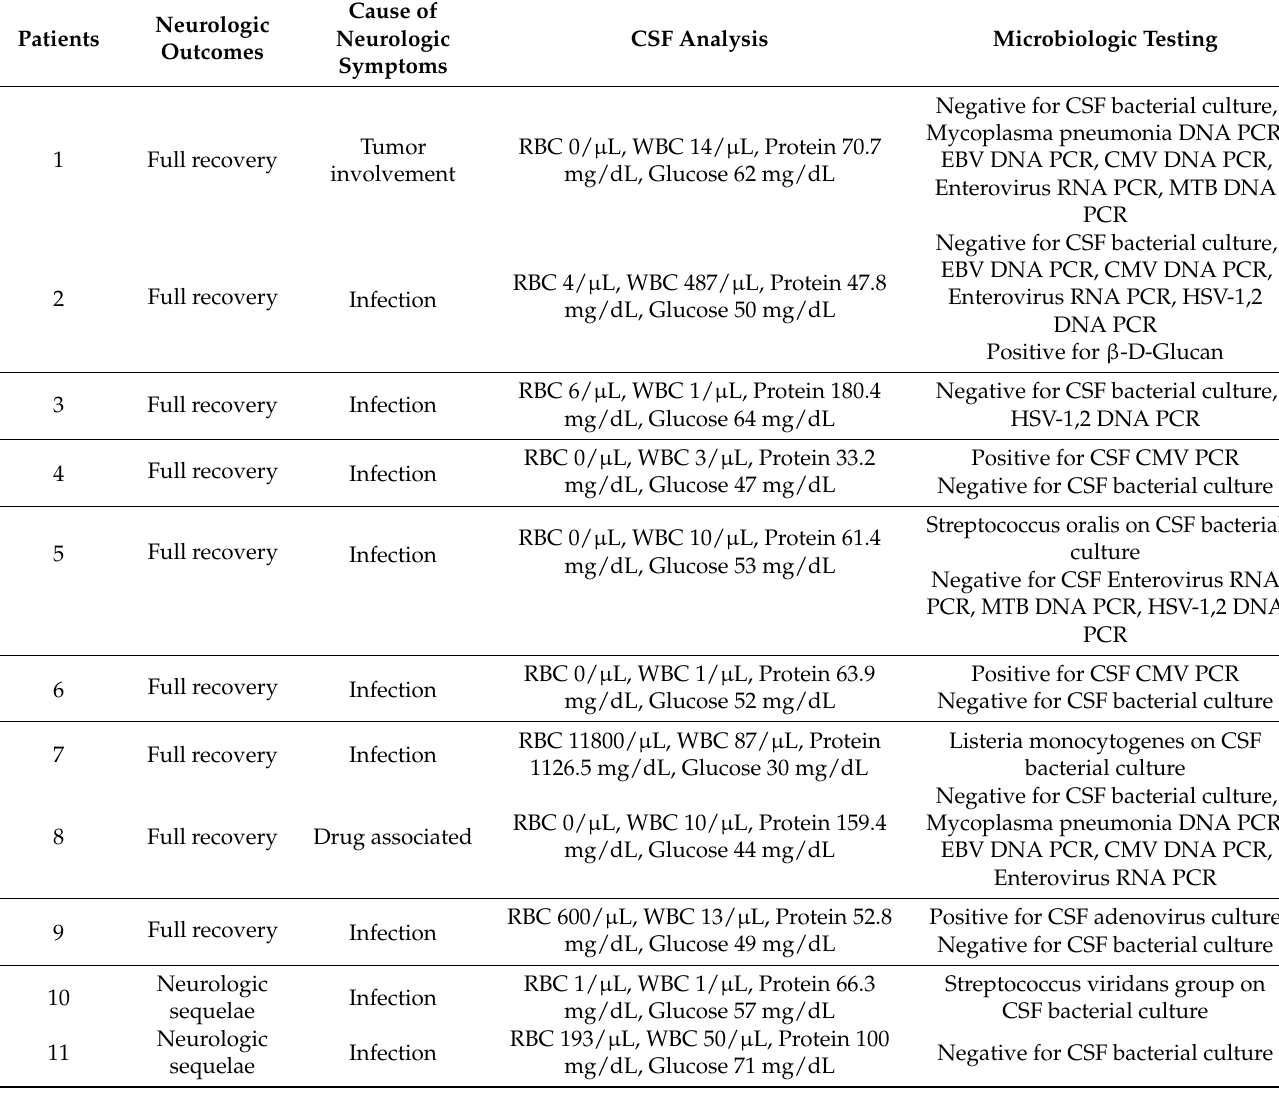
Table A3. CSF Analysis and Microbiological Testing Results of Patients with CSF